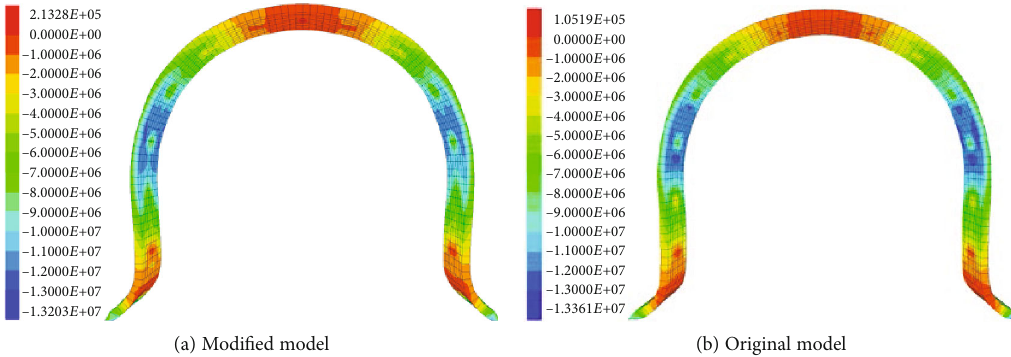
Figure 17: The vertical stress contour of the sprayed layer when the modi fi ed model and the original model arrive at the calculation